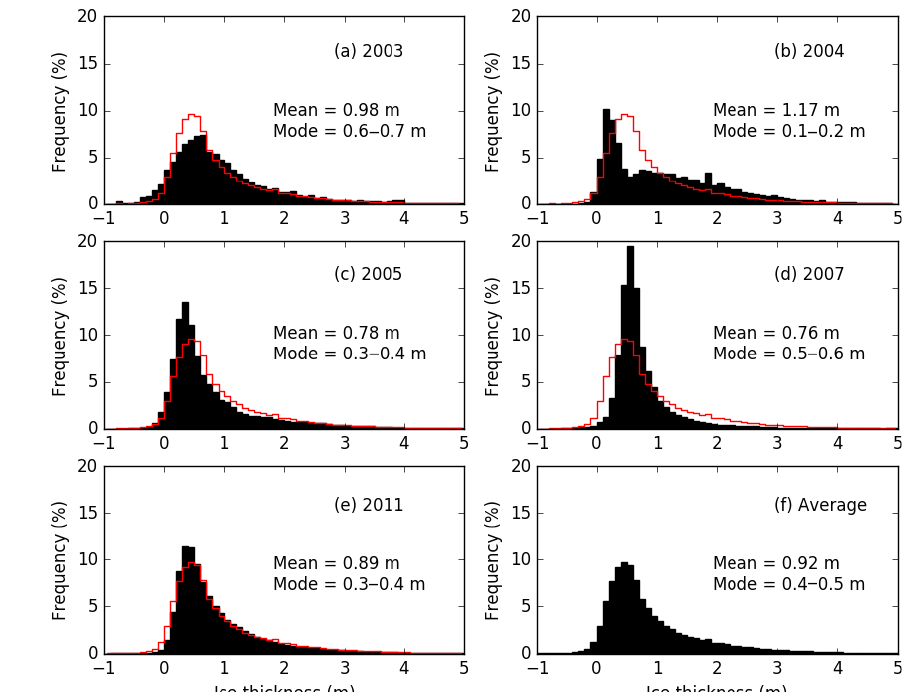
Figure 15. Sea ice thickness distribution in the Bothnian Bay, as estimated from helicopter electromagnetic measurements during February– March in five winters (a–e) , and its five-winter average (f) , also shown as a red line in panels (a–e) . Source: Ronkainen et al., 2018.